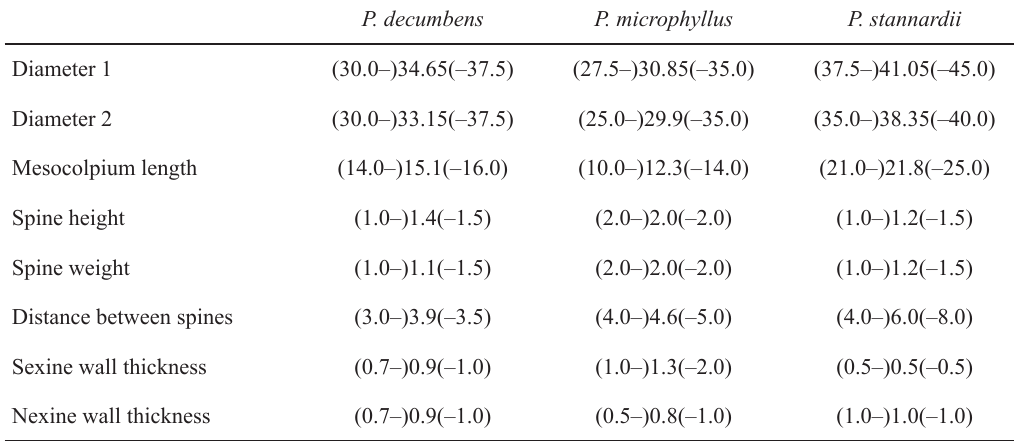
Table 1 – Main morphometrical parameters of pollen morphology of Paepalanthus decumbens , P. microphyllus , and P. stannardii . Measurements of 25 pollen grains from the cited herbarium specimens are all in µm, expressed as (low–)average(–high).